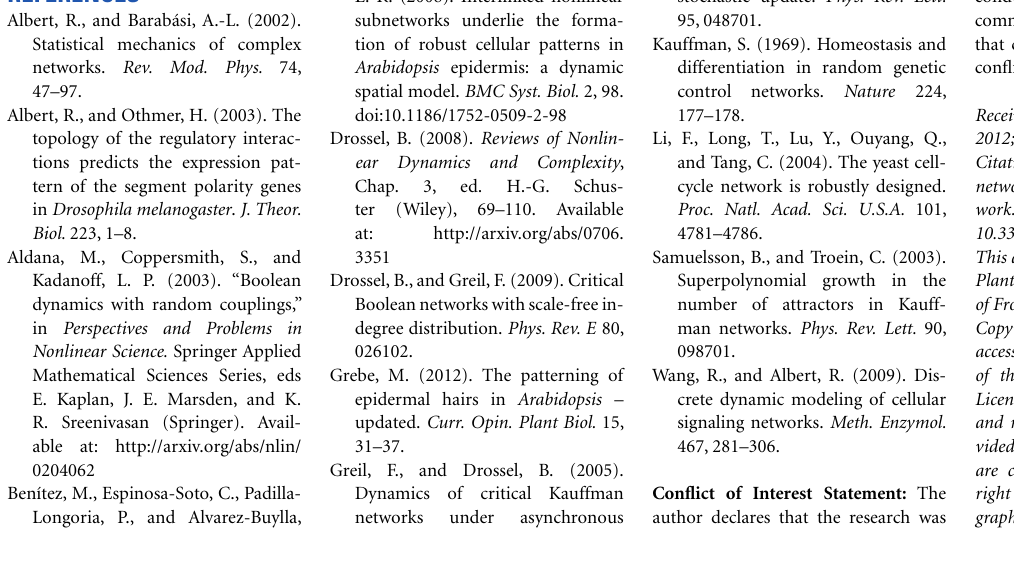
been successfully applied to various gene regulation networks of different species (Wang and Albert, 2009). Let us conclude with showing how the gene regulation network of Arabidopsis thaliana ’s guage and the state space can be simplified. This system is a model experimental system in plant biology (Grebe,2012). Starting